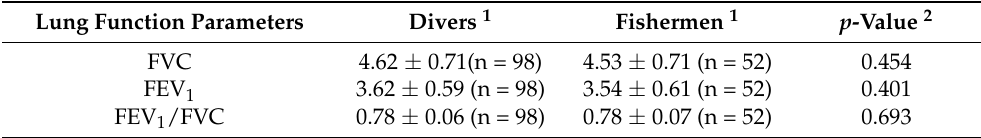
Table 2. Demography and health status of the divers and fishermen. Lung Function